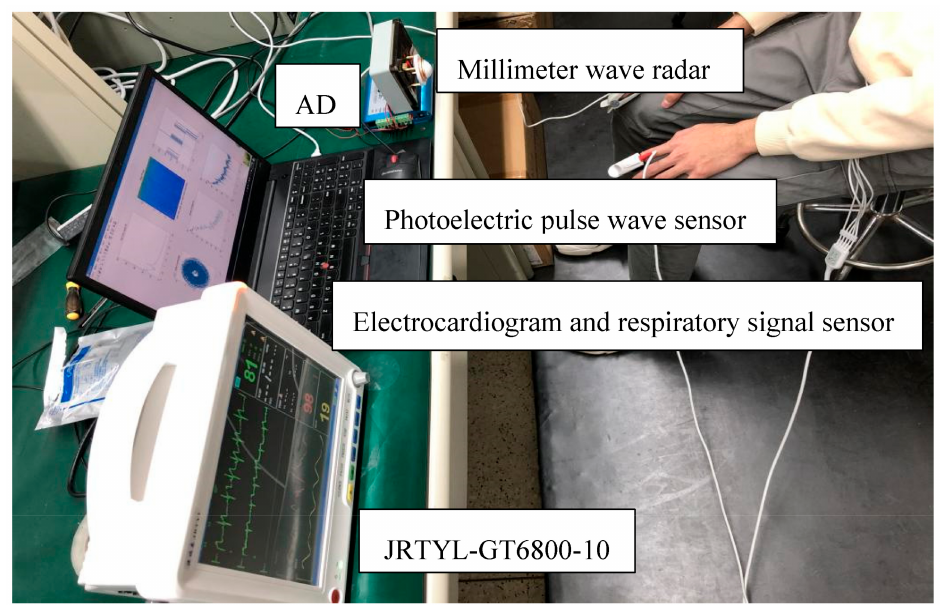
Figure 5. Measurement of respiratory rate and heart